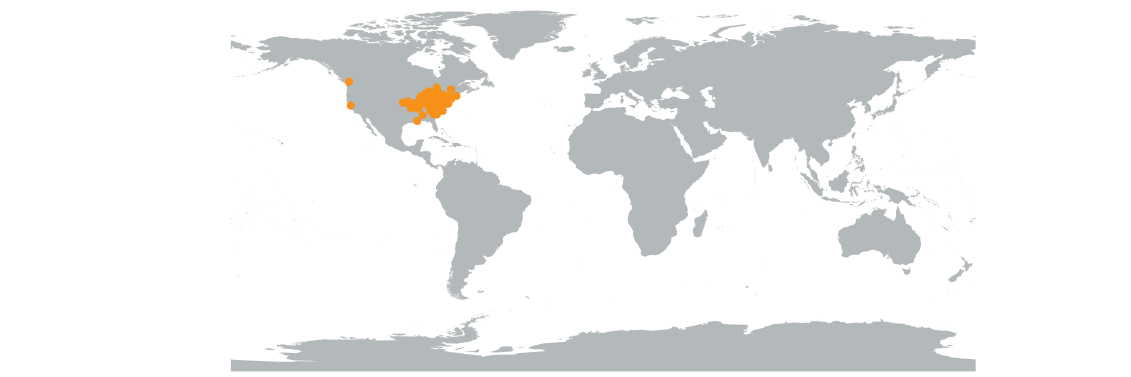
Fig. 51. Distribution of Malus coronaria (L.)